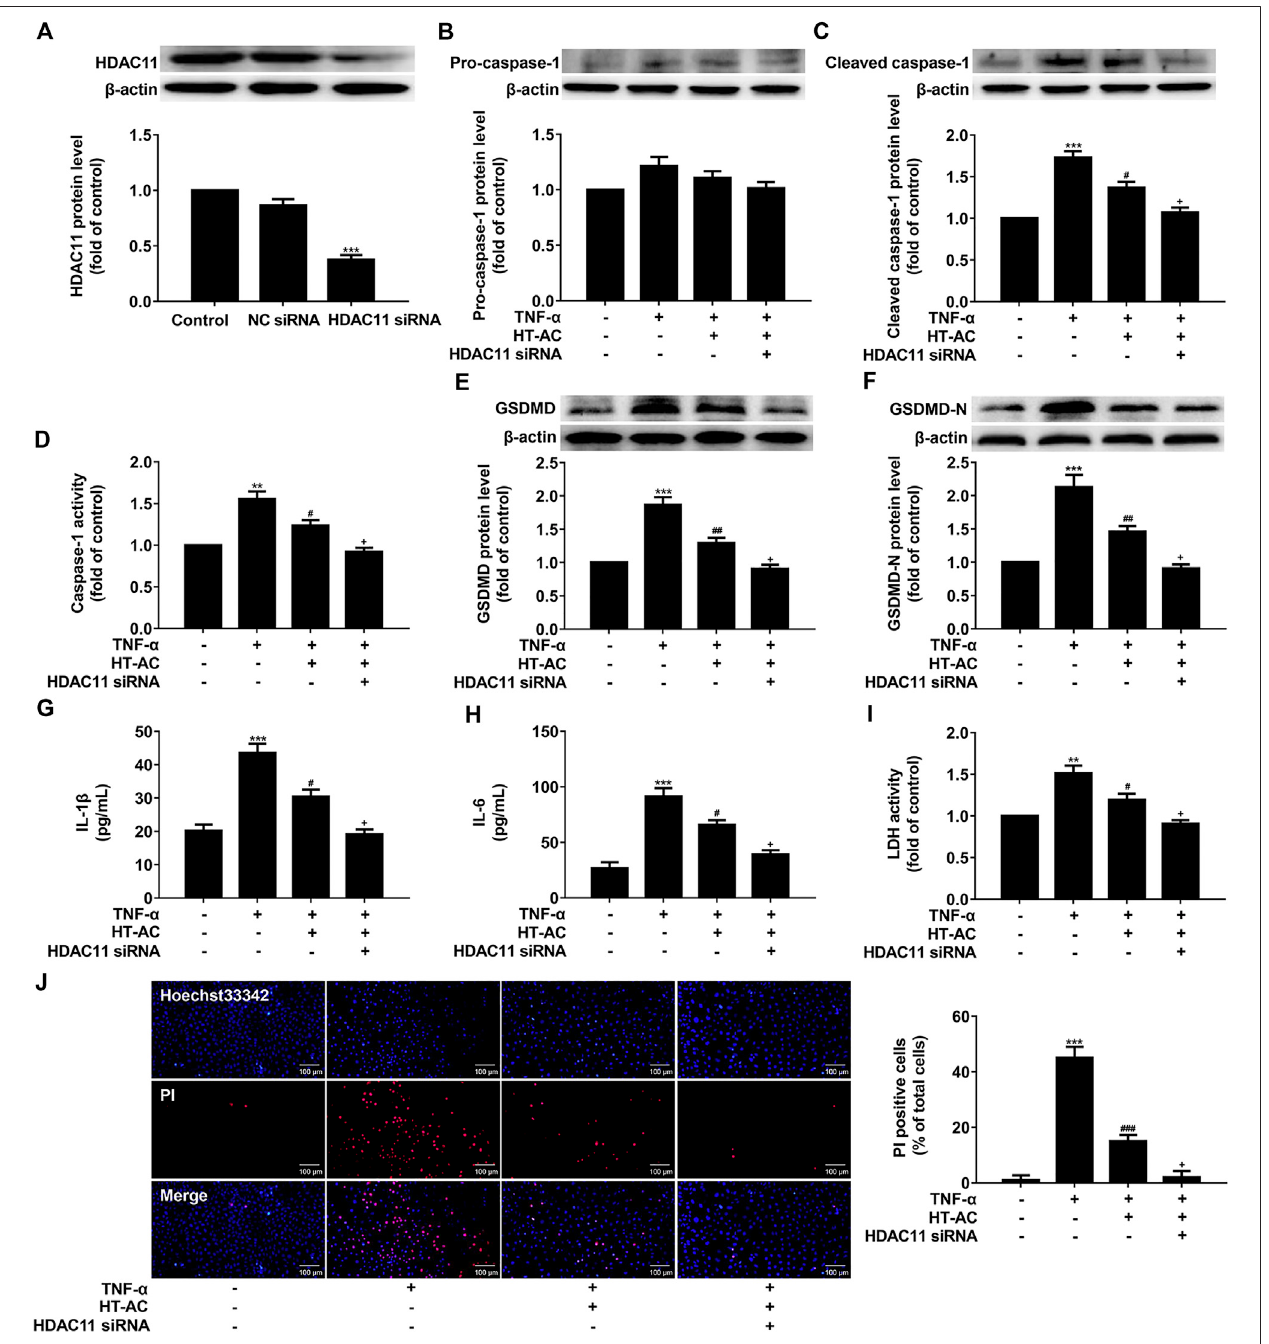
FIGURE 6 | HT-AC inhibited pyroptosis through HDAC11 in TNF- α -induced HUVECs. HUVECs were transfected with HDAC11 siRNA or NC siRNA for 48 h (A) The expression of HDAC11 was determined by Western blotting. The HUVECs transfected with HDAC11 siRNA or NC siRNA were pretreated with HT-AC before stimulation with TNF- α (B,C) The protein expressions of pro-caspase-1 and cleaved caspase-1 were determined by Western blotting (D) Caspase-1 activity was assayed using the caspase-1 activity assay kit (E,F) The protein expressions of GSDMD and GSDMD-N were determined by Western blotting (G,H) The concentrationsofIL-1 β andIL-6incellularsupernatantofHUVECsweredetectedbyELISAassay (I) TheLDHreleasewasevaluatedwithacytotoxicitydetectionLDHkit (J) Double- fl uorescent staining with PI (red) and Hoechst 33,342 (blue) was used to assess the formation of membrane pores during pyroptosis, × 200. Scale bar indicates 100 μ m ** p < 0.01, *** p < 0.001 vs. control group; # p < 0.05, ## p < 0.01, ### p < 0.001 vs. TNF- α group; + p < 0.05 vs. TNF- α +HT-AC group. Results are expressed as mean ± SEM ( n (cid:2)